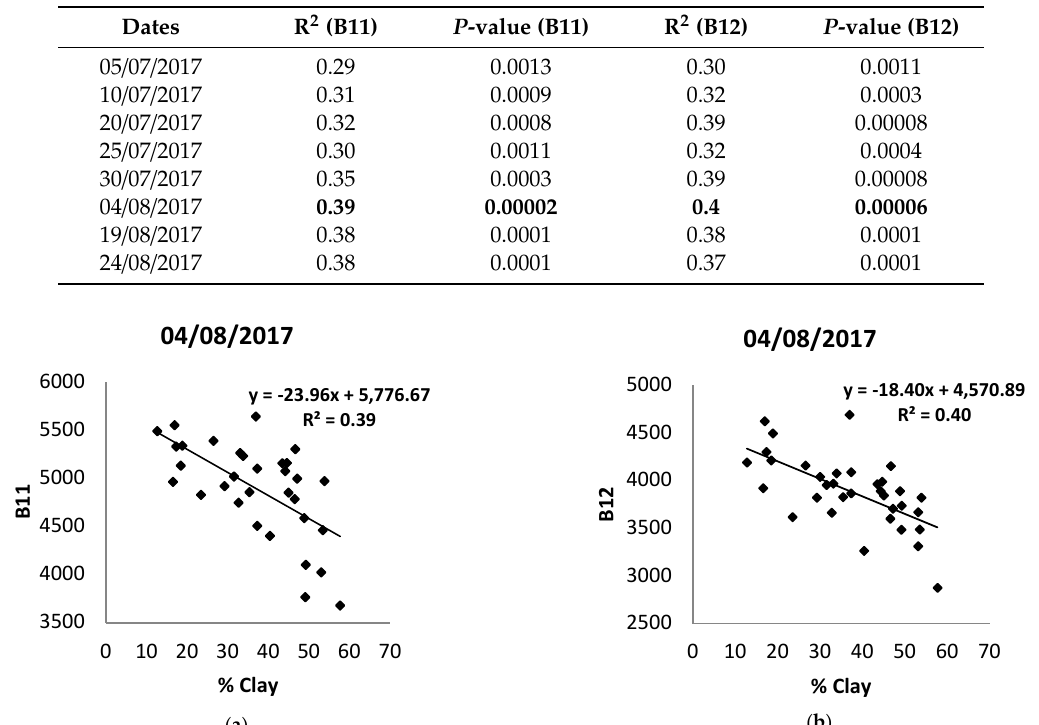
Table 4. Coe ffi cients of determination for the linear regressions computed between clay content and optical reflectance, in bands B11 and B12 of the S-2 images recorded on eight di ff erent dates during the summer of 2017; bolded numbers correspond to the best accuracy.